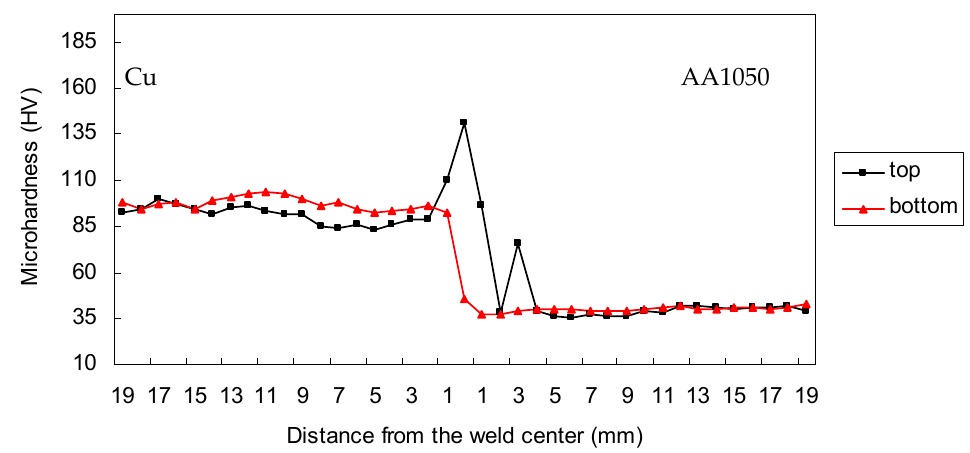
Figure 12. Hardness profile on the transverse cross section of the 630/50/1 specimen.